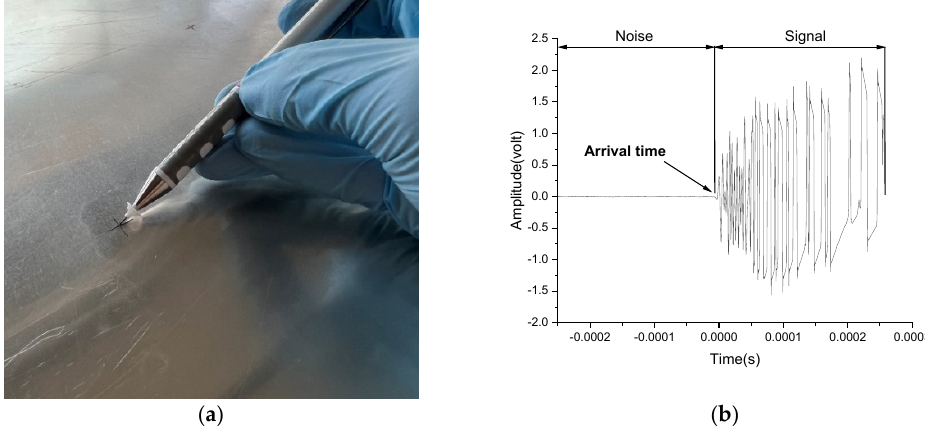
Figure 15. Measurement event generated and data collected: ( a ) pencil leading; ( b ) example of measured signals.